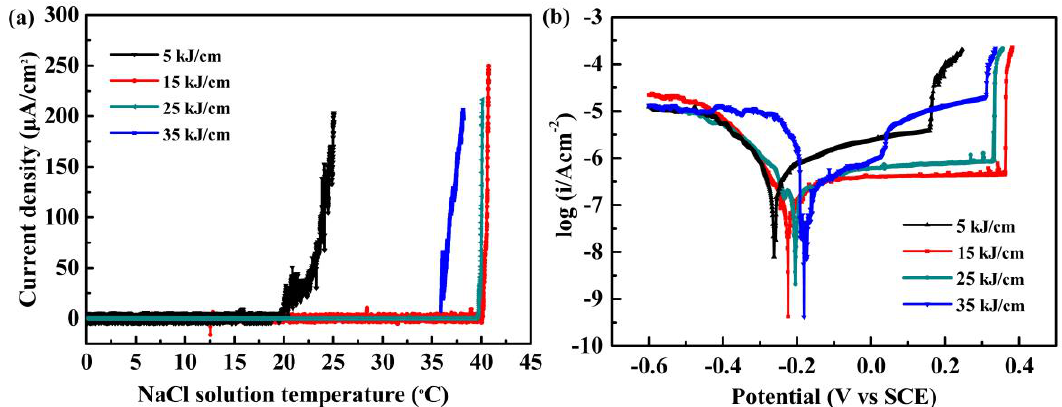
Figure 3. ( a ) The current density plots under 250 mV SCE in 1 M NaCl solution in the critical pitting temperature (CPT) test; ( b ) the potentiodynamic polarization curves in 3.5 wt.% NaCl